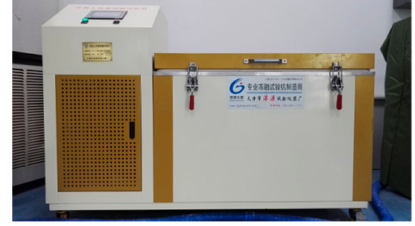
Figure 16. The rapid cyclic freeze-thaw